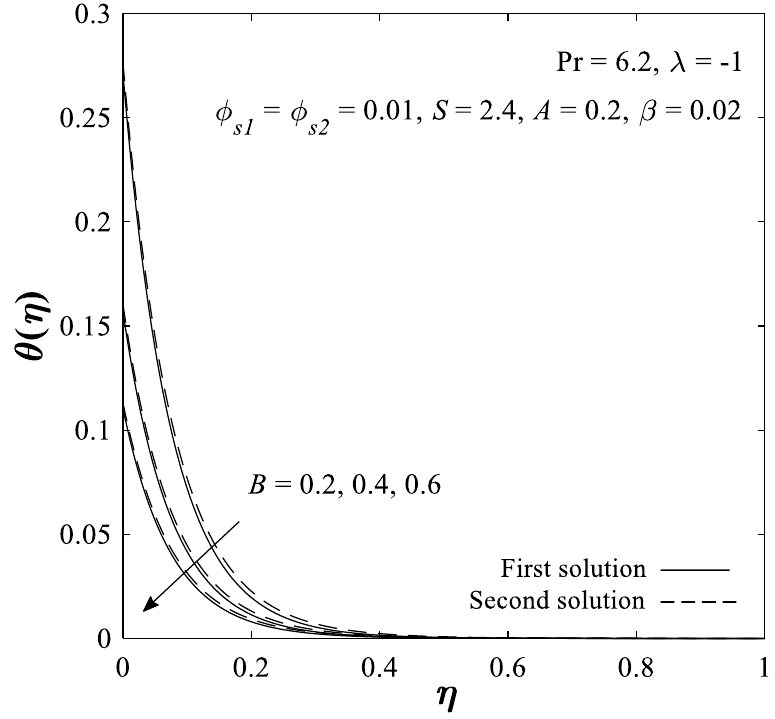
. Figure 15. Temperature profile θ ( η ) for varied φ s 2 . 2 s